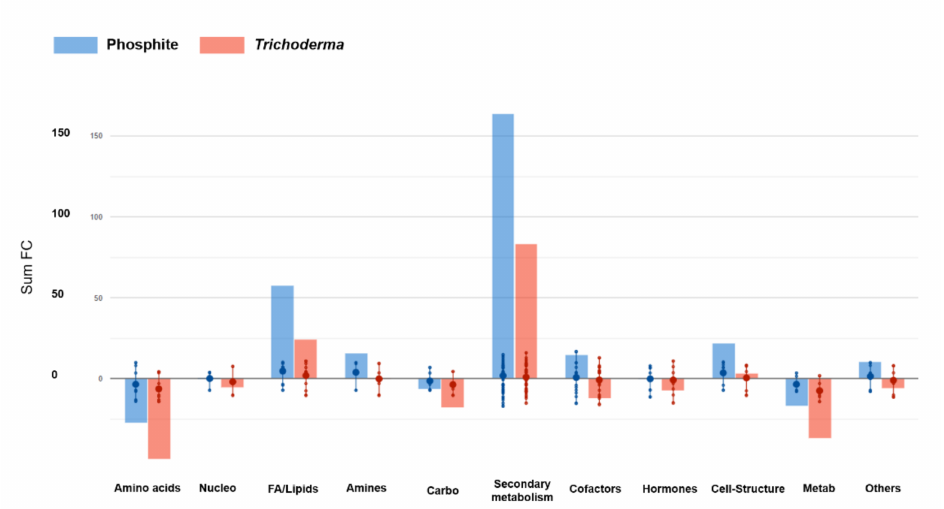
Figure 3. Biosynthetic pathways affected in plants treated with Trichoderma and phosphite. Differen- tial metabolites and their fold-change (FC) values were elaborated using the Omic Viewer Dashboard of the PlantCyc pathway Tool software (www.pmn.plantcyc.com; Accessed on 3 December 2020). In each class, the large dot represents the average (mean) logFC of the metabolites. Small dots represent the individual logFC for each metabolite. The abbreviated subcategory names on the x-axis correspond to the biosynthesis of: Nucleo: nucleosides and nucleotides; FA/Lipids: fatty acids and lipids; Amines: amines and polyamines; Carbo: carbohydrates; Cofactors: cofactors, prosthetic groups, electron carriers, and vitamin; Metab: metabolism